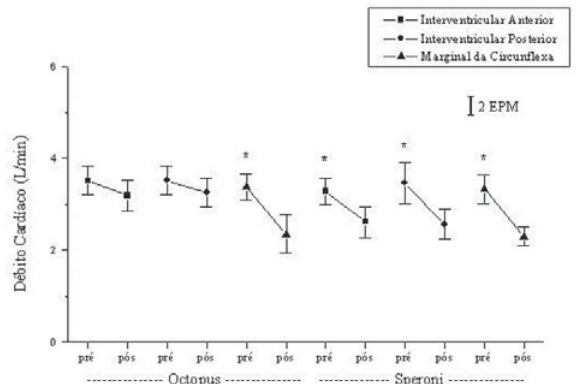
Fig. 1 - Débitos cardíacos pré e pós-estabilização com o Octopus e o Speroni. Valores médios com dois erros padrões da média (EPM). (*) diferença com significância estatística